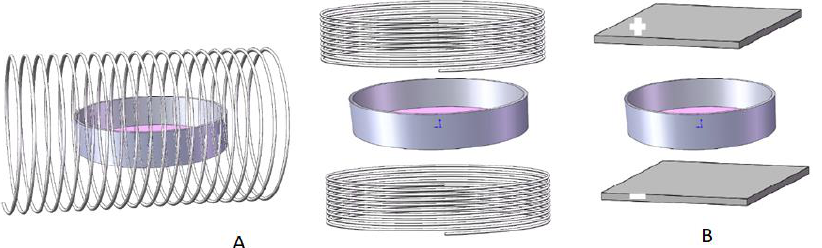
Figure 4. Two designs offering noninvasive ES. ( A ) ES through EMF, where a cell culture plate is placed inside a Helmholtz coil in parallel to the direction of MF, or in perpendicular to the direction of MF between two Helmholtz coils; ( B ) ES through capacitive coupling where a culture plate is sandwiched between two paralleled plates (note: the distance between plates and culture should be minimum to reduce resistance).